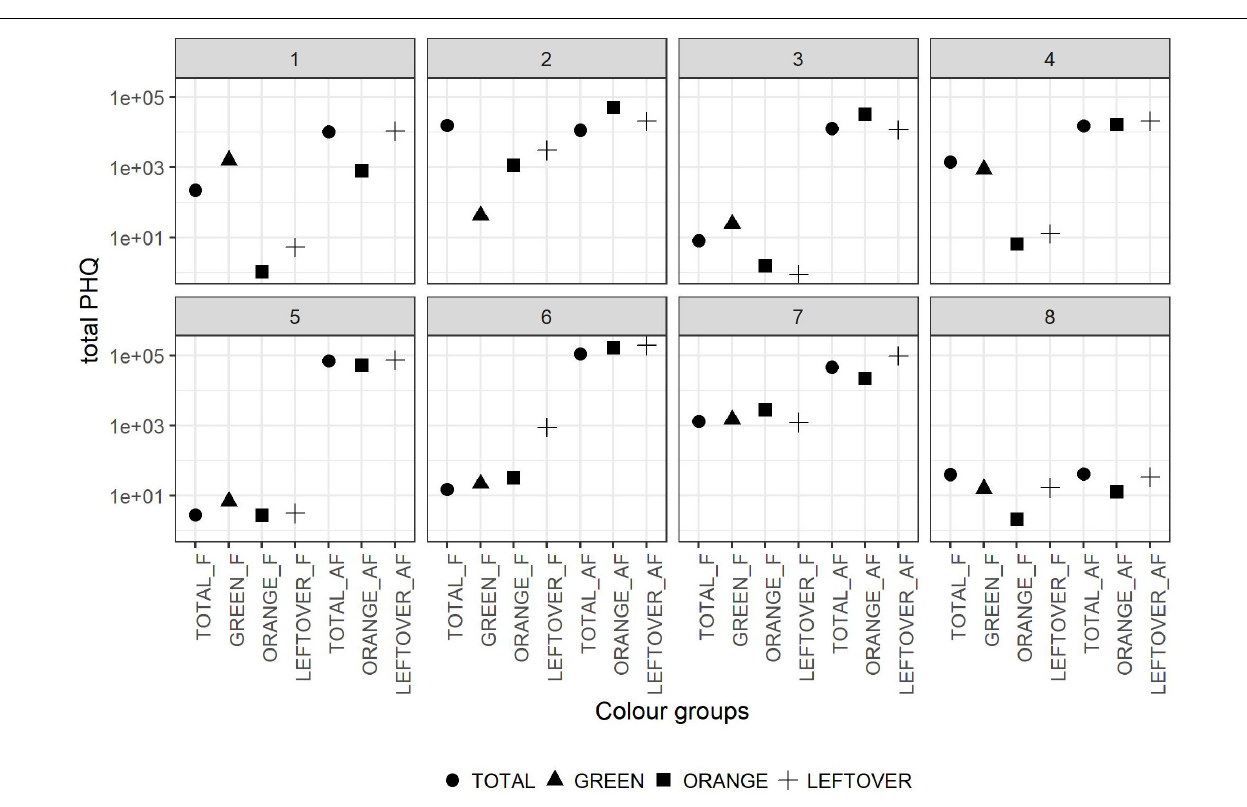
Frontiers in Physiology |